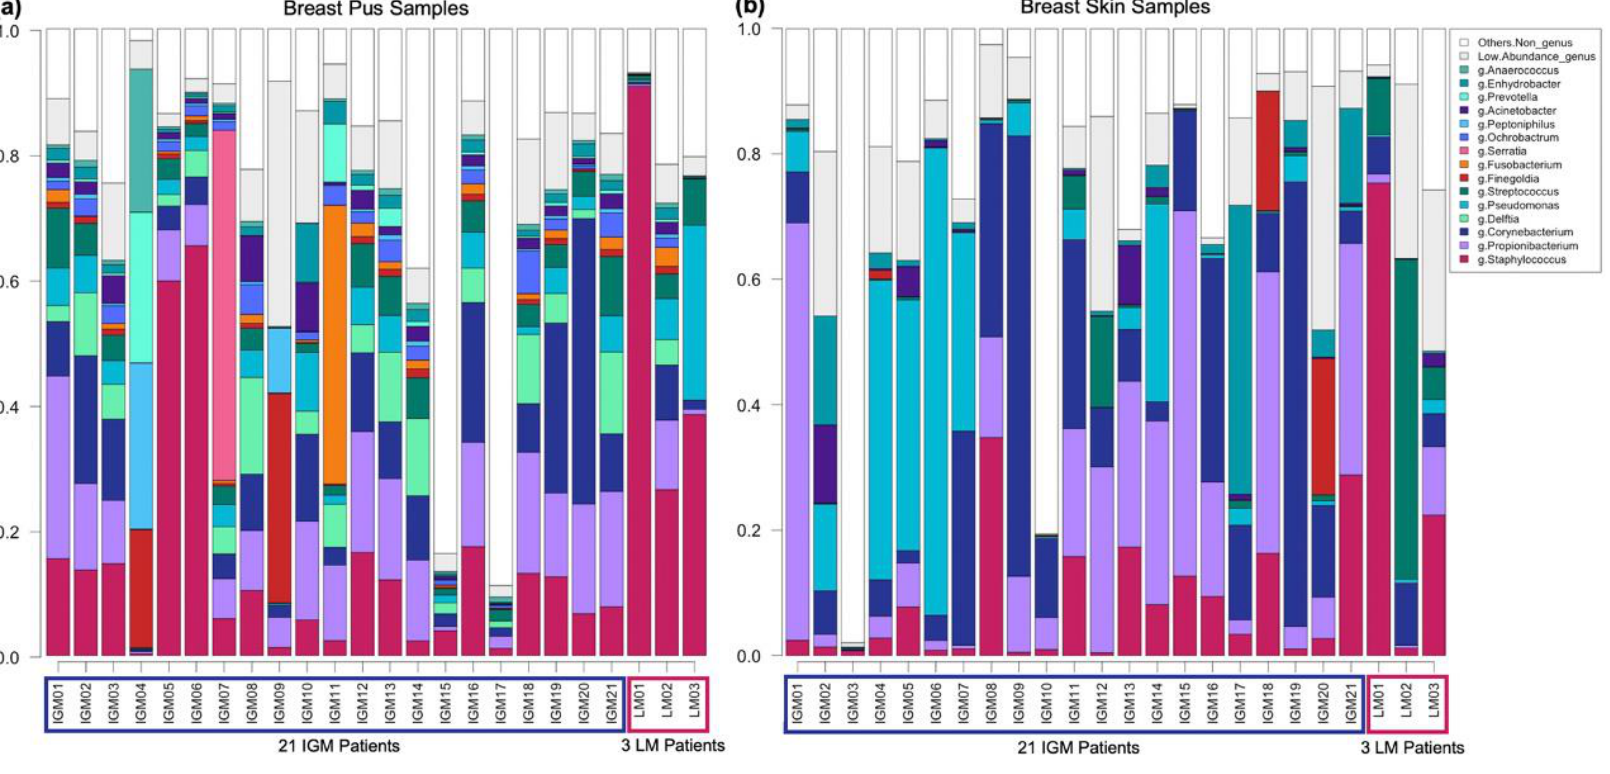
Figure 1. Bar graph of genus taxonomic profiles of breast ( a ) pus and ( b ) skin samples. A metagenomic analysis compared the relative abundances of bacterial taxa of pus samples from 21 patients with idiopathic granulomatous mastitis (IGM) and three control patients with lactating mastitis (LM) (LM01, LM02, and LM03). Each bar represents a ( a ) pus or ( b ) skin sample from a patient. The genus level taxonomic units with relative abundance ≥1% are represented, with corresponding colours indicated in the shared figure key for ( a , b ) on the right. Genus taxonomic units with relative abundance <1% are collapsed into “Low Abundance”, and taxonomic units higher than genus level classification are collapsed into “Others”. ( a ) Genera Staphylococcus dominates the three LM pus samples (LM1-3): 90.8%, 26.5%, and 38.5%, respectively. Bacteria profiles in IGM pus samples differ from LM, without a dominant genus across pus samples, and greater variability between patients; ( b ) No dominant genus is observed across either the IGM or LM skin samples, collectively or as separate groups. Corynebacterium contributes more to skin than pus microbiota in both IGM and LM samples, although Corynebacterium appears at higher relative abundances for IGM skin samples than LM skin samples. Again, inter-patient variability is considerable. IGM: Idiopathic granulomatous mastitis; LM: Lactational